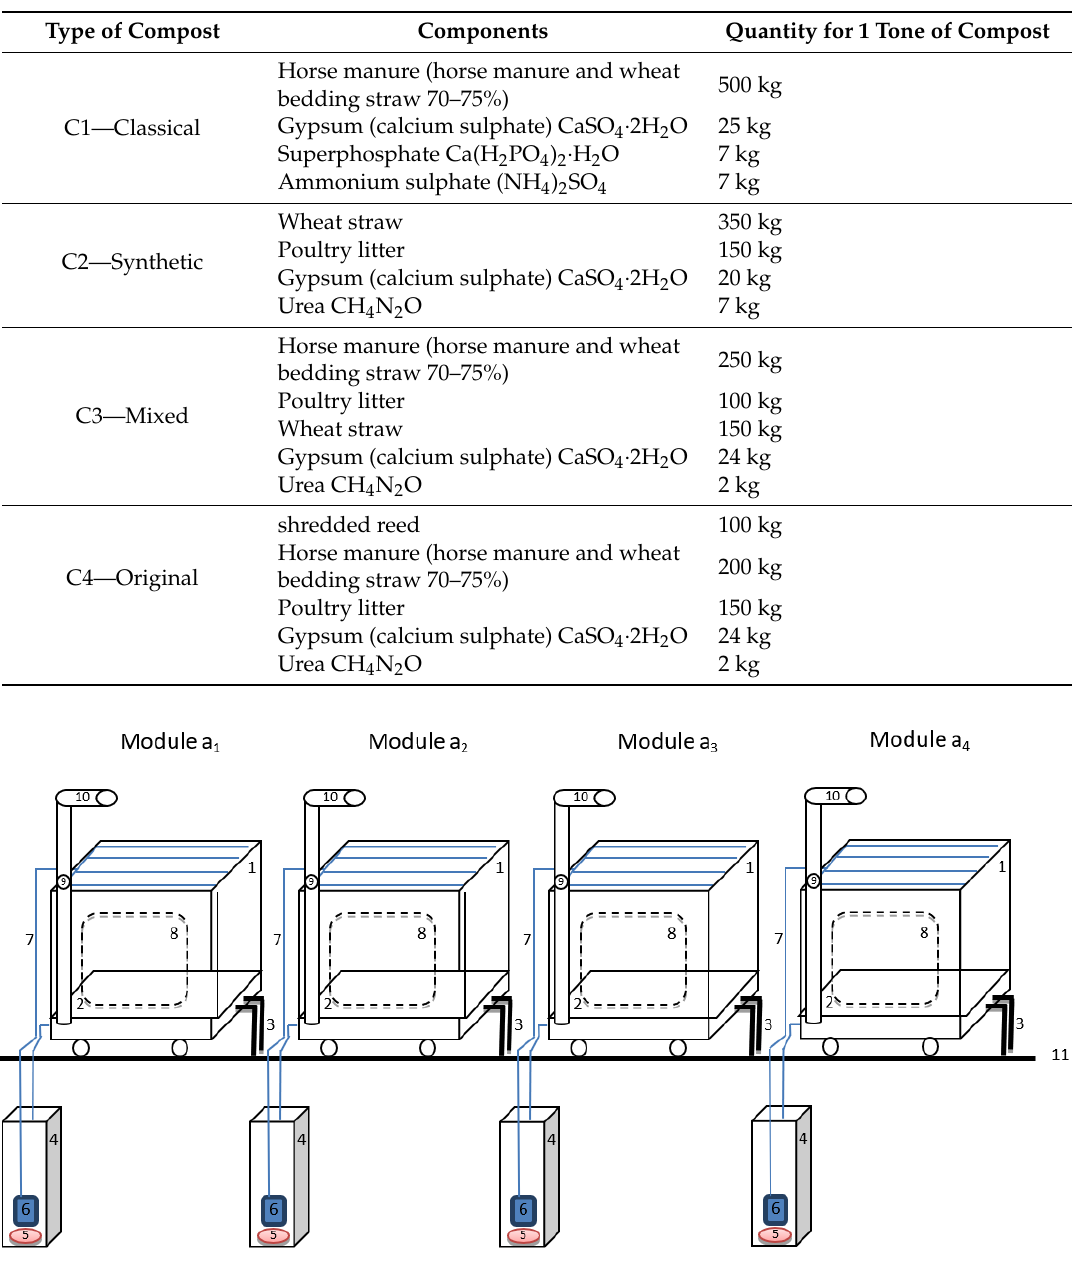
Figure A1. Sketch for the composting facility—4 modules